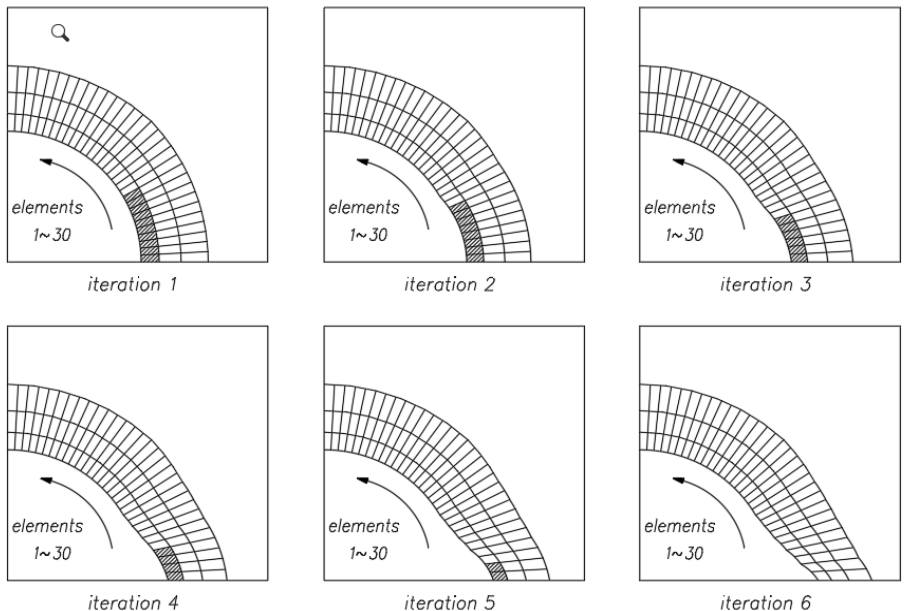
Figure 9. Changing of breakout region in the process of breakouts.